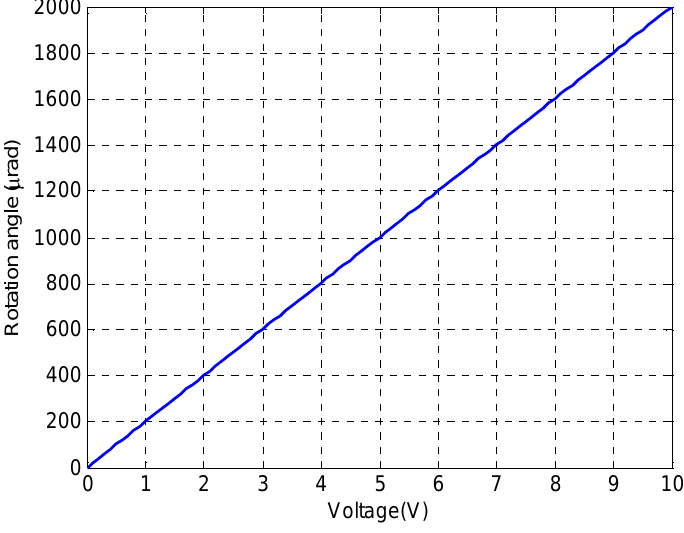
Figure 7. Relationship between the sensor output voltage and its angle displacement.